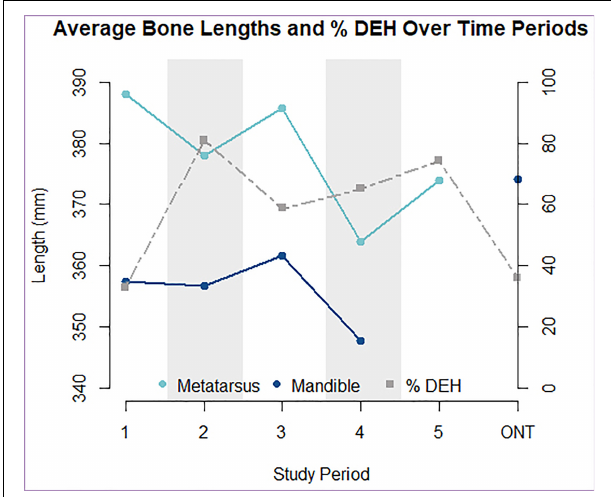
FIGURE 4 | Inverse relationship between average metatarsus and mandible lengths (solid lines) and percent of individuals with DEH (dashed line) present per time period and locality. High density periods are indicated with shading. Data plotted here can be found in Table 1 .